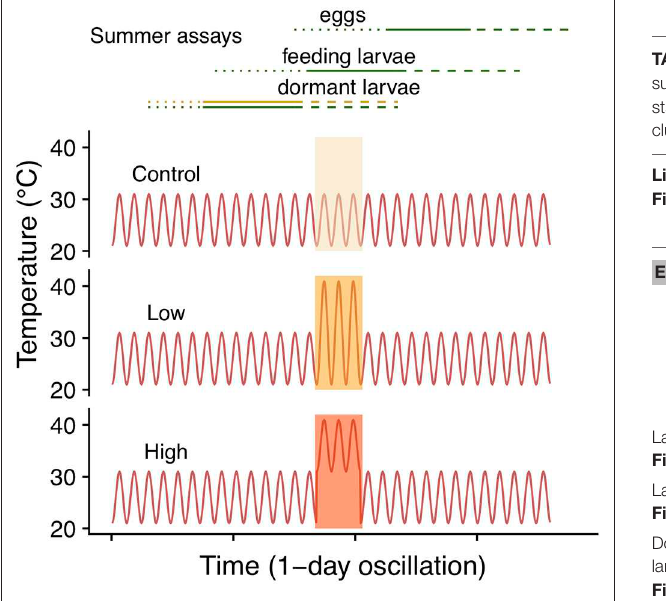
FIGURE 2 | Summer heatwave temperature regimes. Lines in the top panel correspond to the different sets of clutches included in each of the three summer assays. Lines designate eggs (dotted), feeding (solid) and dormant (dashed) larvae. Colors indicate host, green for C. glabra and yellow for ( P. lanceolata ), only the dormant larvae assay included both hosts.